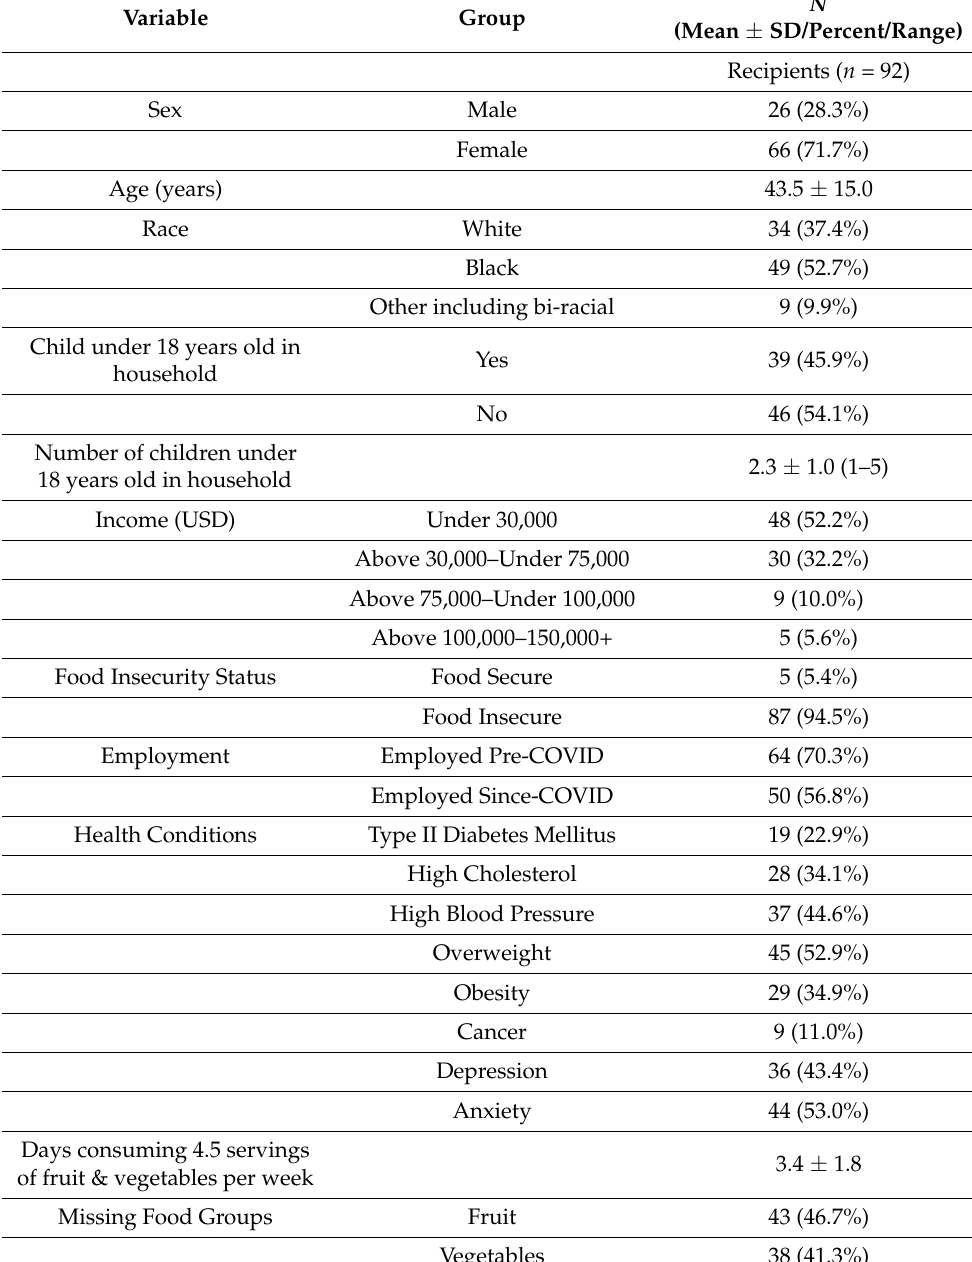
Table 1. Descriptive Statistics by Recipient and Non-Recipient